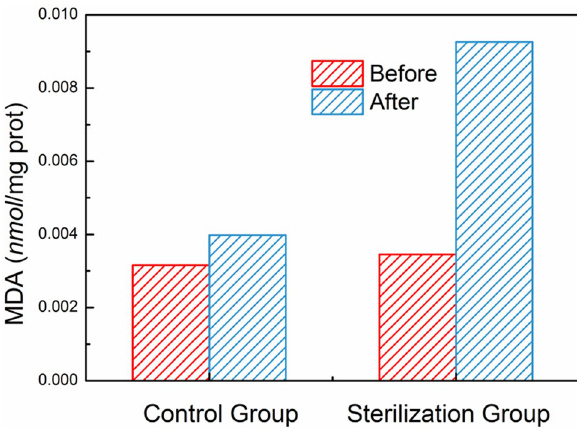
Figure 7. MDA concentrations before and after